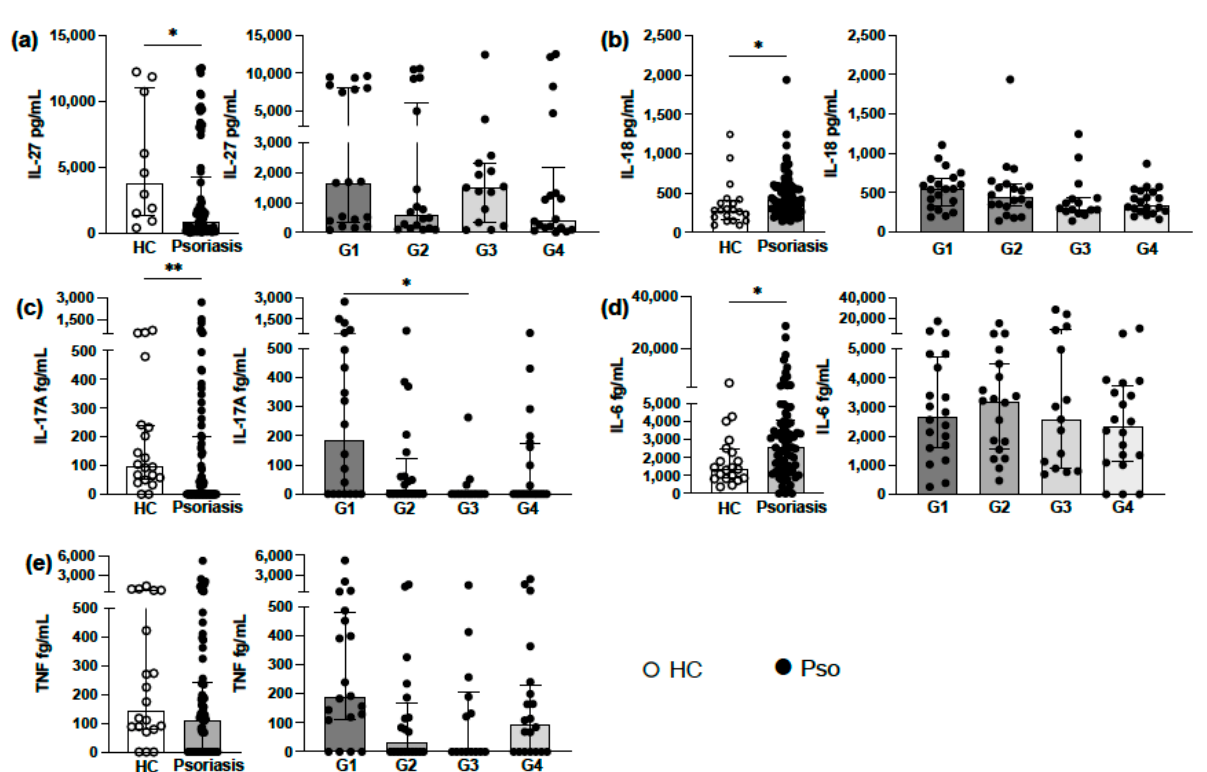
Figure 1. Circulating levels of proinflammatory cytokines in psoriasis. ( a ) Decreased levels of IL-27 in psoriasis (Pso, n = 75) compared to healthy controls (HC, n = 10). There was no statistical difference between Pso groups. G1 showed more prominent alterations. ( b – e ) Increased levels of IL-18, IL-17A, IL-6 and TNF in Pso group ( n = 75) compared to HC ( n = 20). When analyzing cytokines levels in Pso groups, we detected increased levels of IL-17A in G1 ( c ). G1—biologics treatment;